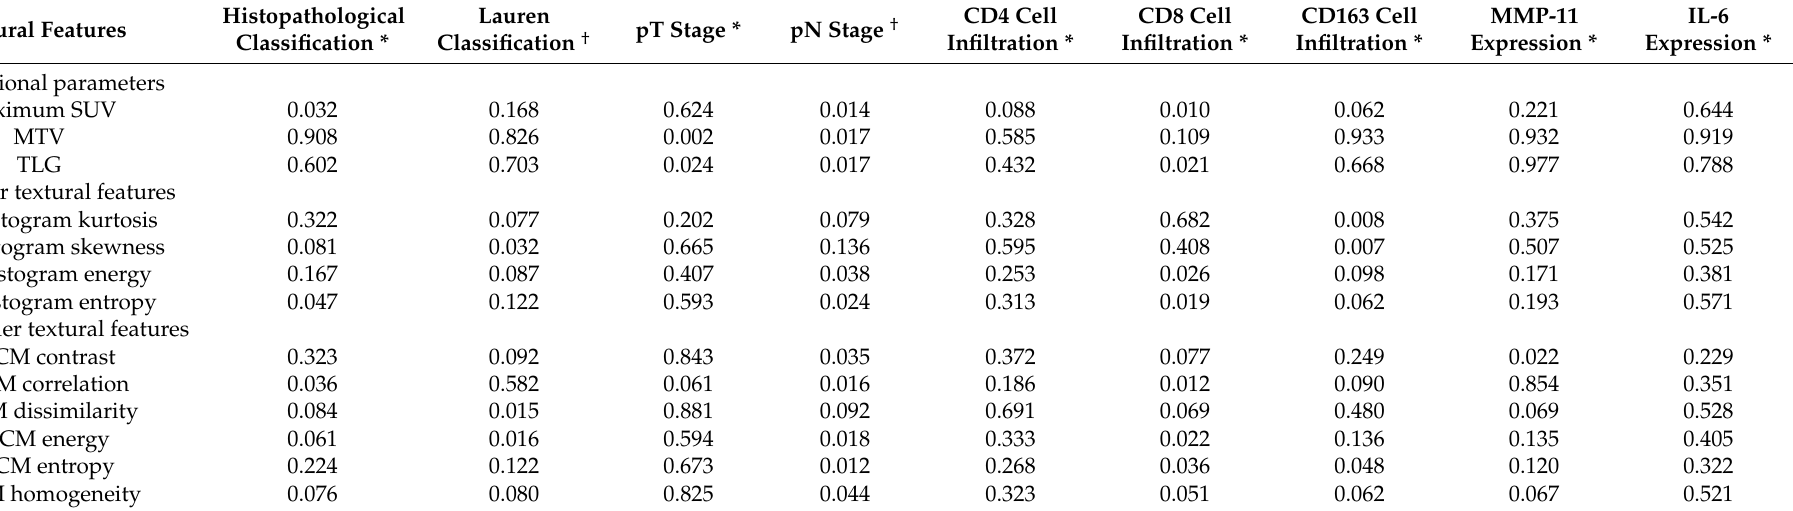
Table 2. Statistical significance ( p -value) of comparisons of textural features of primary gastric cancer on FDG PET/CT according to the histopathological